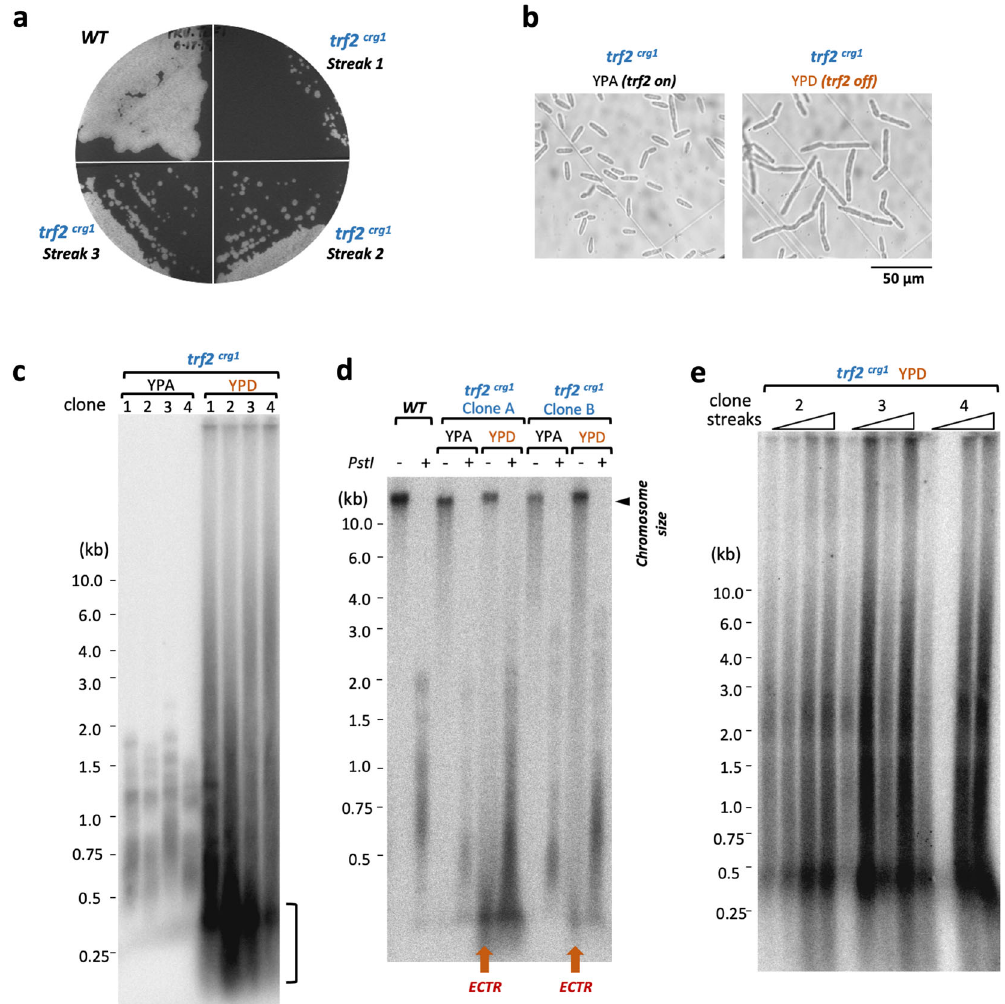
Fig. 5 Ustilago maydis Trf2 is critical for cell proliferation and telomere protection. a A trf2 crg1 clone was passaged on YPD (a medium that represses trf2 transcription), and the growth of the clone at successive streaks assessed along with the parental strain. The plates were incubated at 30 °C for 3 days. b A trf2 crg1 clone was grown in liquid YPA or YPD, and examined under the microscope. c DNAs from multiple, independently constructed trf2 crg1 mutants that had been grown in YPA or YPD were subjected to TRF Southern analysis. d Untreated or Pst I-digested chromosomal DNAs were fractionated on agarose gel, transferred to nylon membrane, and then subjected to Southern hybridization using a TTAGGG 82 probe. The short telomere fragments that can be detected in the absence of Pst I digestion are highlighted as extra-chromosomal telomere repeats (ECTR). e Multiple independent trf2 crg1 clones were passaged on YPD plates by repeated re-streaking. DNAs from liquid culture out-growth of the resulting colonies were subjected to telomere restriction fragment Southern